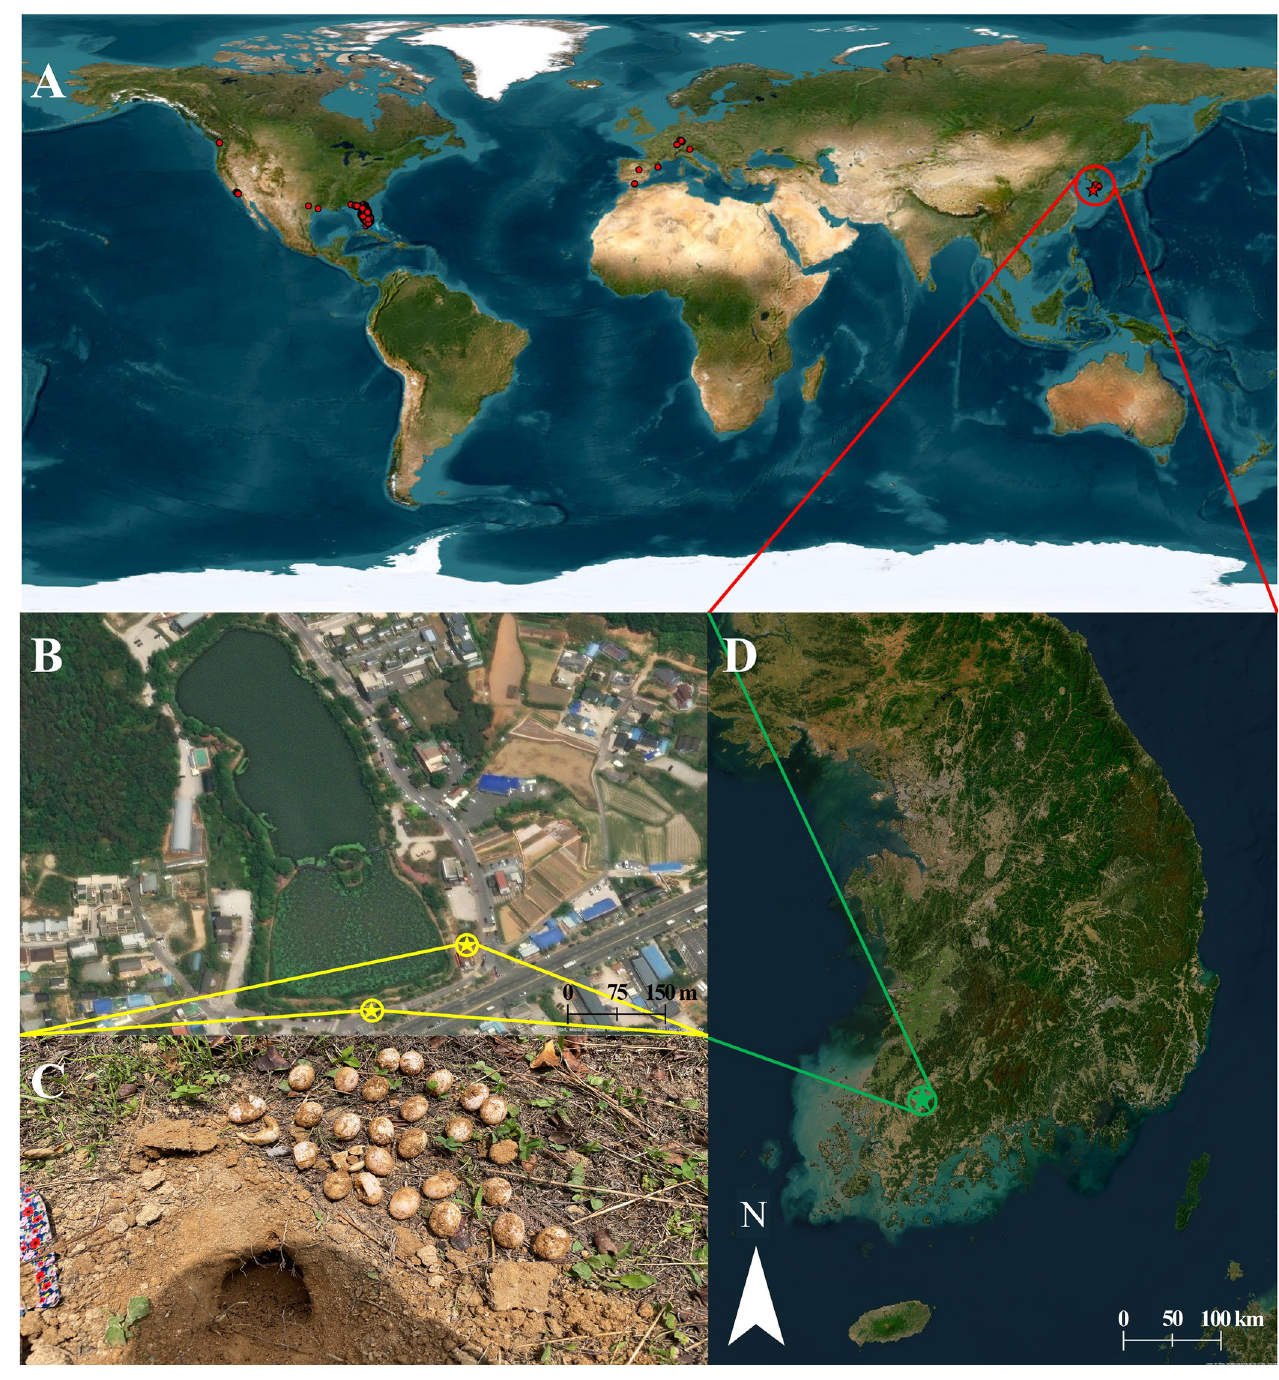
Fig 1. Distribution of Pseudemys peninsularis and the study area. (A) Distribution of P . peninsularis across the world. The red star indicates the location of South Korea. (B) Jeonpyeongje Neighborhood Park with the nest sites indicated by the yellow stars. (C) A nest with P . peninsularis eggs. (D) Map of South Korea with study site at Gwangju indicated by a green star. The maps and satellite images were generated using Arcmap 10.8.1 (ESRI, USA; https://support.esri. com/en/products/desktop/arcgis-desktop/arcmap/10-8-1).